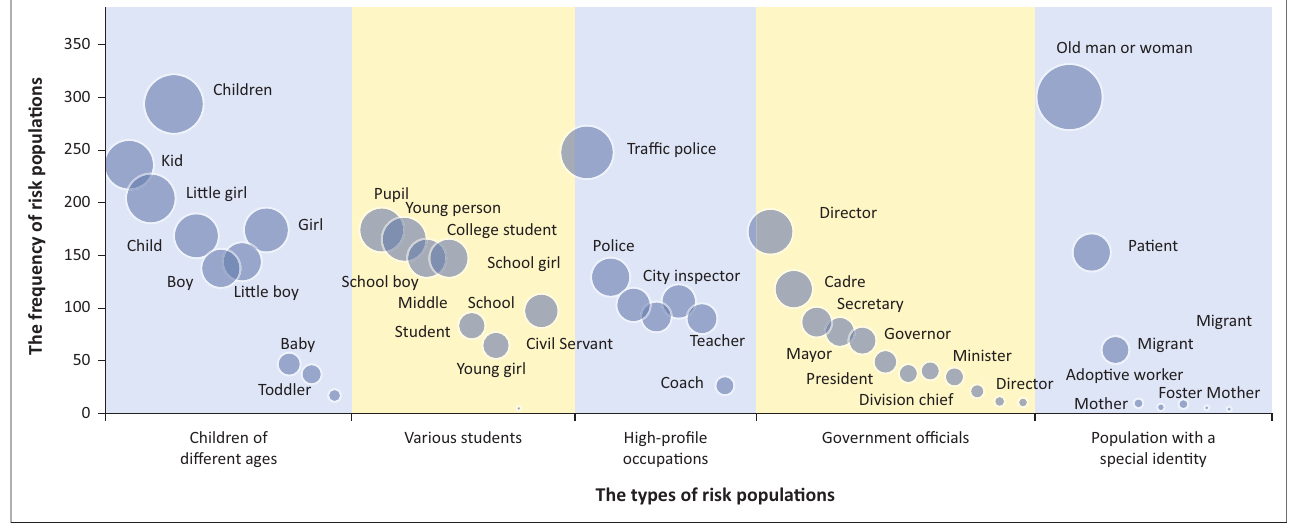
FIGURE 8: Frequency of various types of risk populations of emergencies.